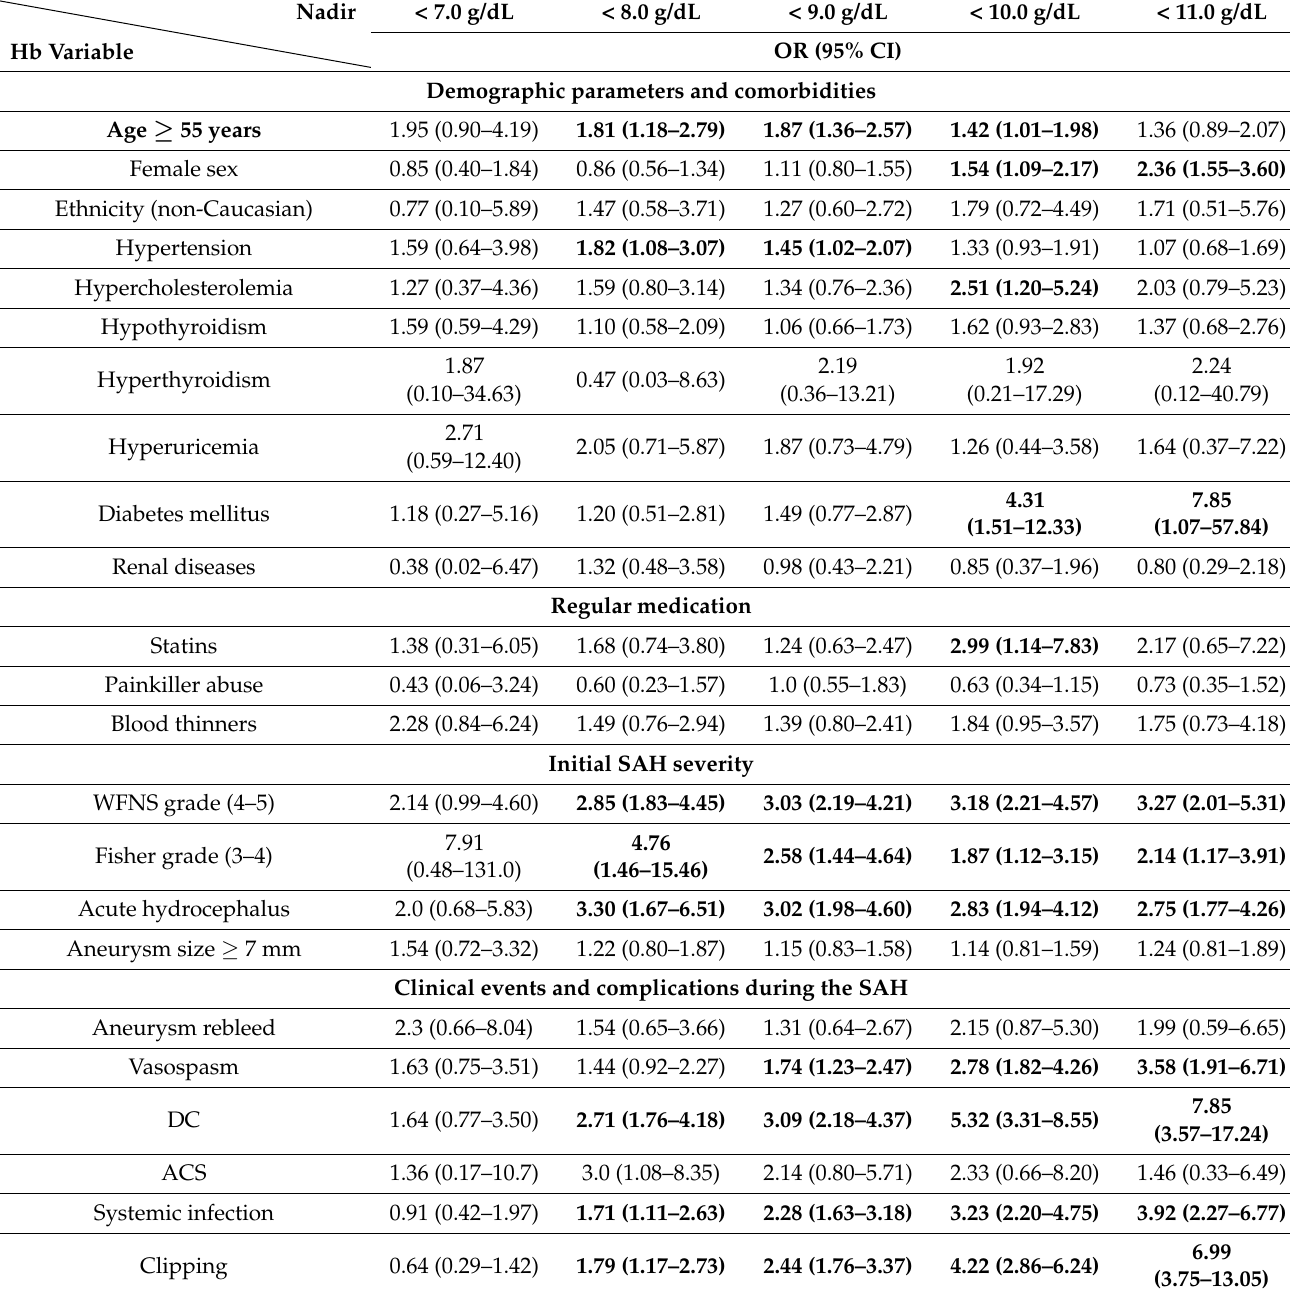
Table 2. Univariate analyses of baseline characteristics as predictors of anemia in